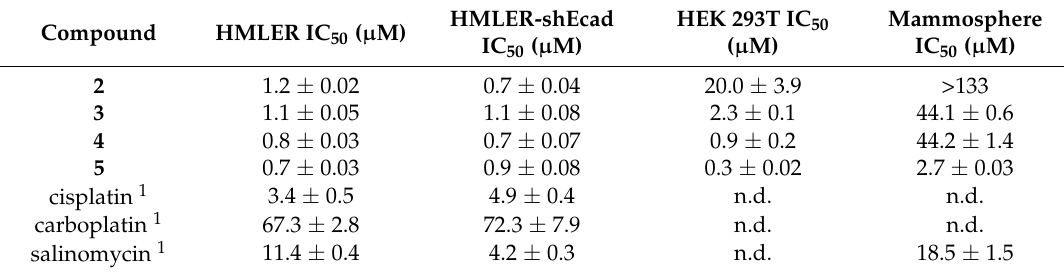
Table 1. IC 50 values of 2 – 5 , salinomycin, cisplatin, and carboplatin against HMLER, HMLER-shEcad, and human embryonic kidney (HEK) 293T cells, and HMLER-shEcad mammospheres. Incubation times of 72 h or 120 h were used. IC 50 values and errors represent the mean value of three independent experiments and the associated standard deviations, respectively.